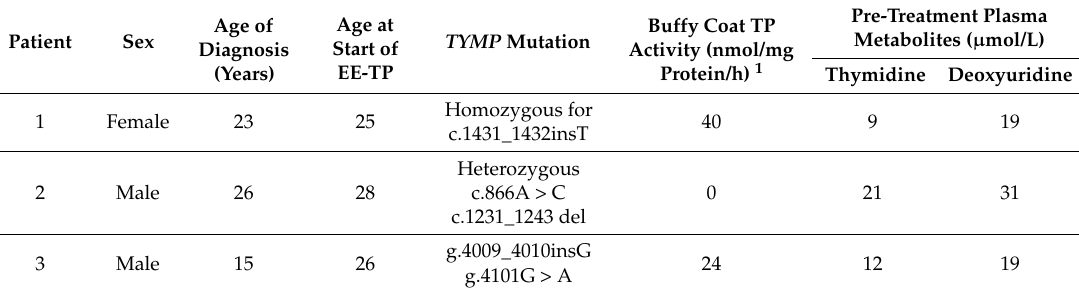
Table 1. Subject demographics and baseline disease